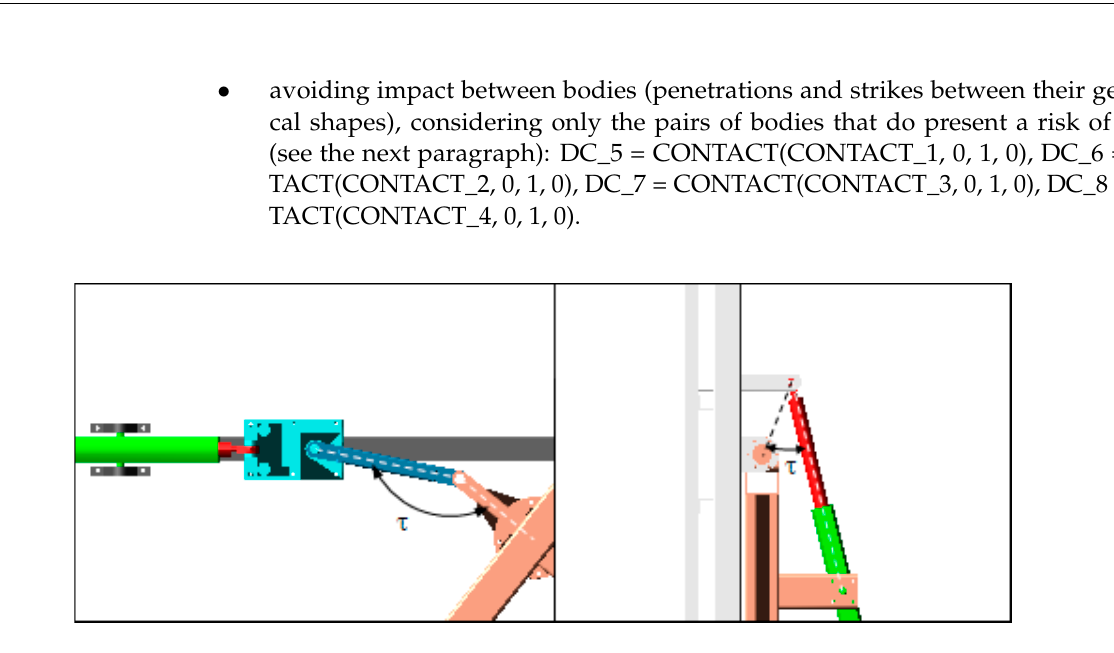
Figure 7. Transmission angle in the motion subsystems of the proposed bi-axial tracking mecha- nism.